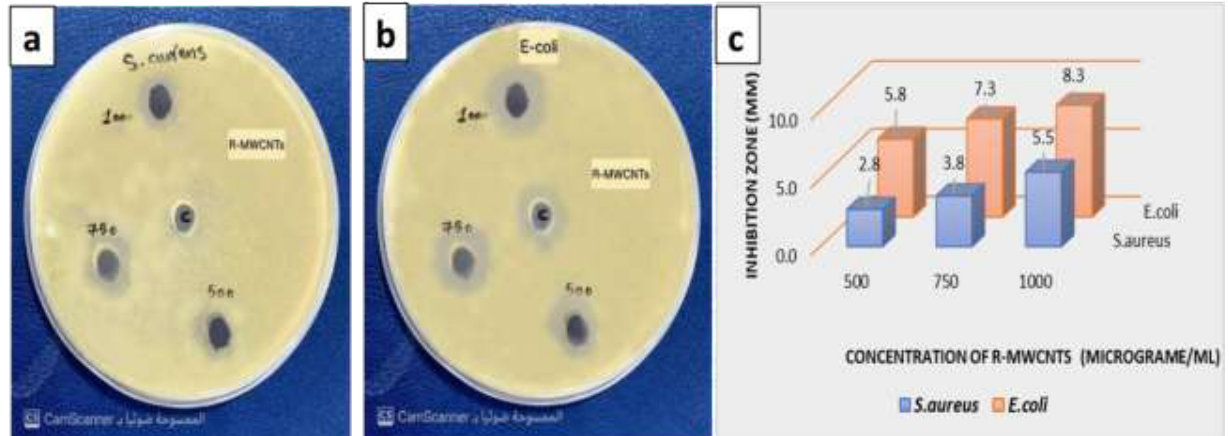
Figure 7: Inhibition Zone diameter (IZ) around well filled with different concentrations of antibacterial R- MWCNTs against a) S. aureus , b) E. coli and c) Bar diagram of antibacterial